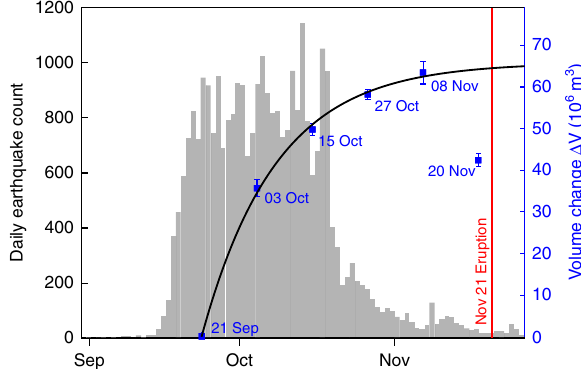
Sep Fig. 5 Relationship between the rate of seismic activity and the emplacement of the magma intrusion. Time series show the daily number of seismic events (grey) and the volume history of the intrusion (blue). The volume changes, Δ V t , have been inferred from the time-step inversion of InSAR descending stacks by using an inverse fi nite element model (see Methods). Values are well fi t by an exponential decay: Δ V t = Δ V